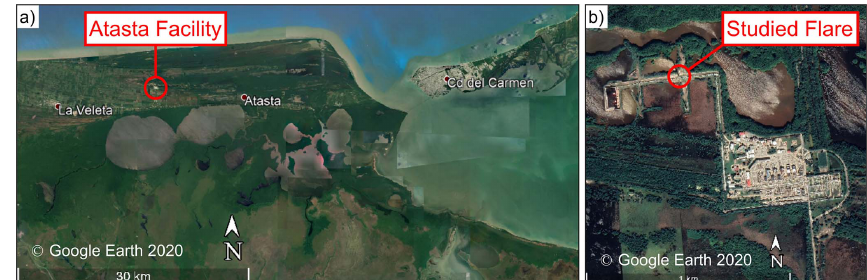
Figure 7. (a) Location of the Atasta Gas Processing and Transport Centre in the Mexican state of Campeche, 35km west of Ciudad (Cd) del Carmen and approximately 5km south of the Bay of Campeche. (b) Location of the flare that is the focus of the case study located in the northwest corner of the site amongst other flaring